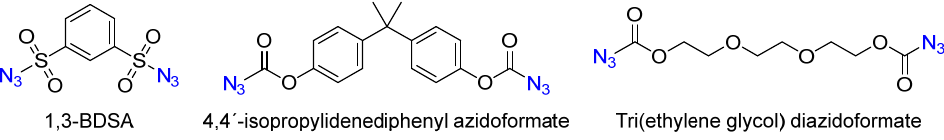
Figure 9. Bisazide crosslinkers for dynamic vulcanization.